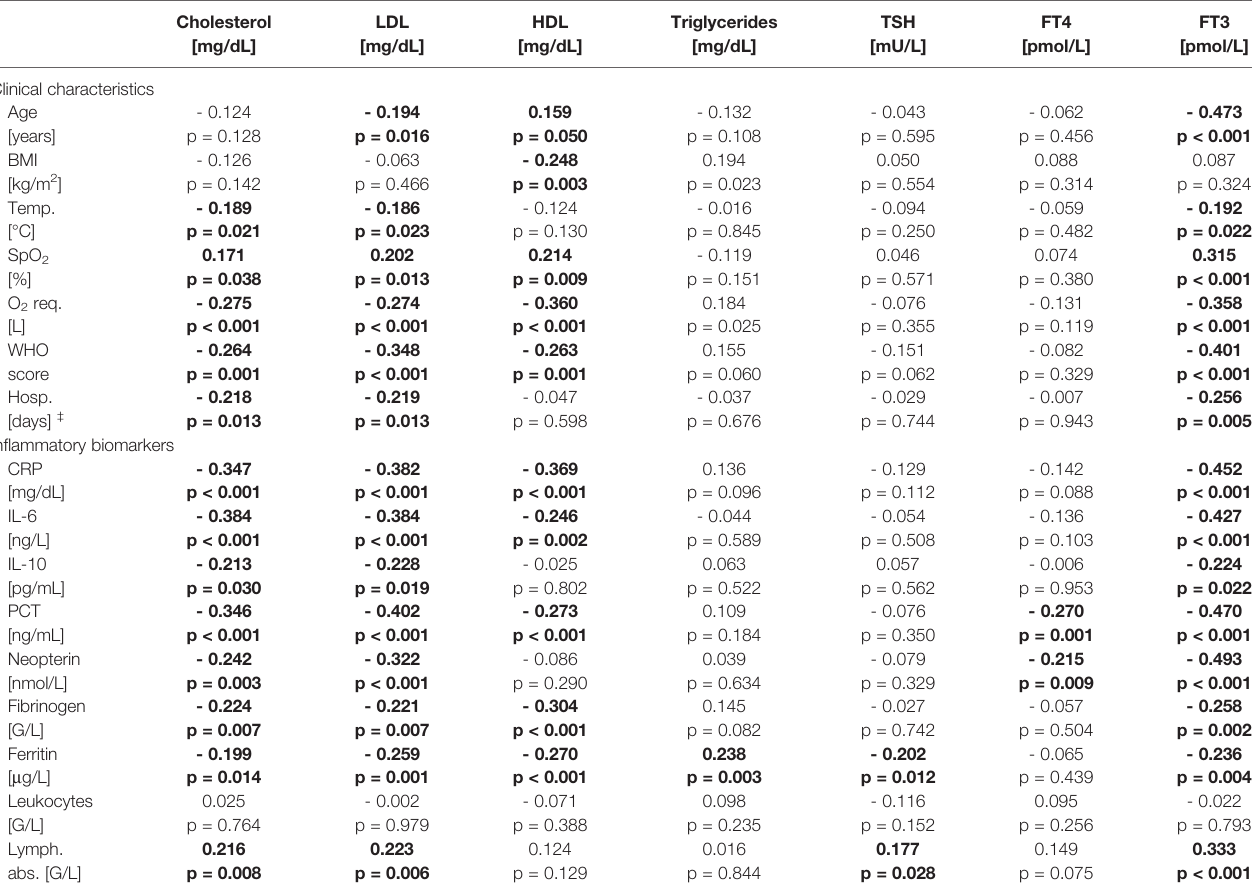
TABLE 2 | Correlations of lipoproteins and thyroid hormones with clinical characteristics and laboratory parameters in